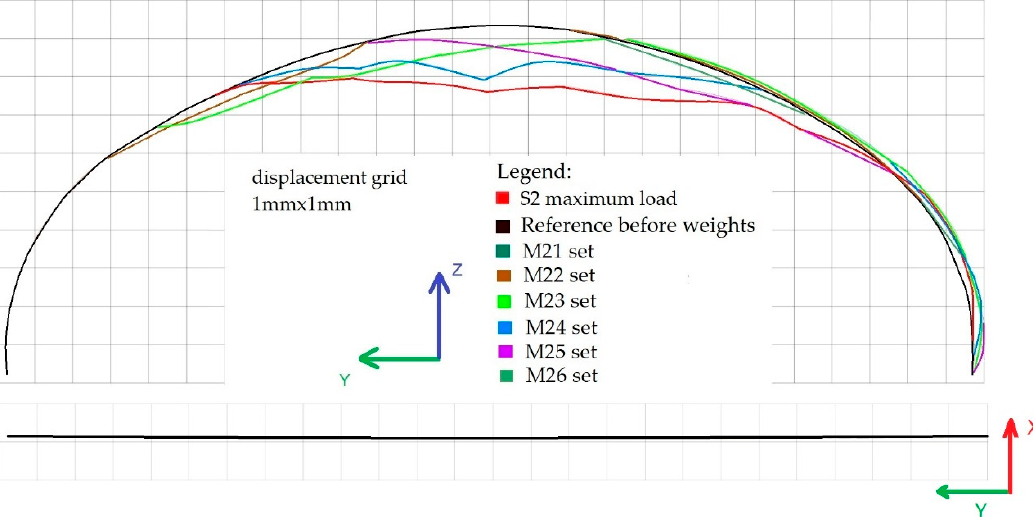
Figure 14. Deformations of the bridge cross section 4-4 in the Y-Z (top) and X-Y (bottom) planes under loading schemes S2 and M21–M26.